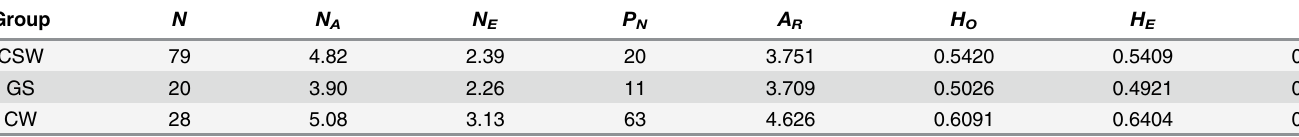
Number of analyzed individuals ( N ), mean number of alleles across all studied loci ( N A ), mean number of effective alleles per locus ( N E ), total number of private alleles ( P N ), mean allelic richness corrected by sample size ( A R ), observed ( H O ) and expected ( H E ) heterozygosity, inbreeding coef fi cient ( F IS